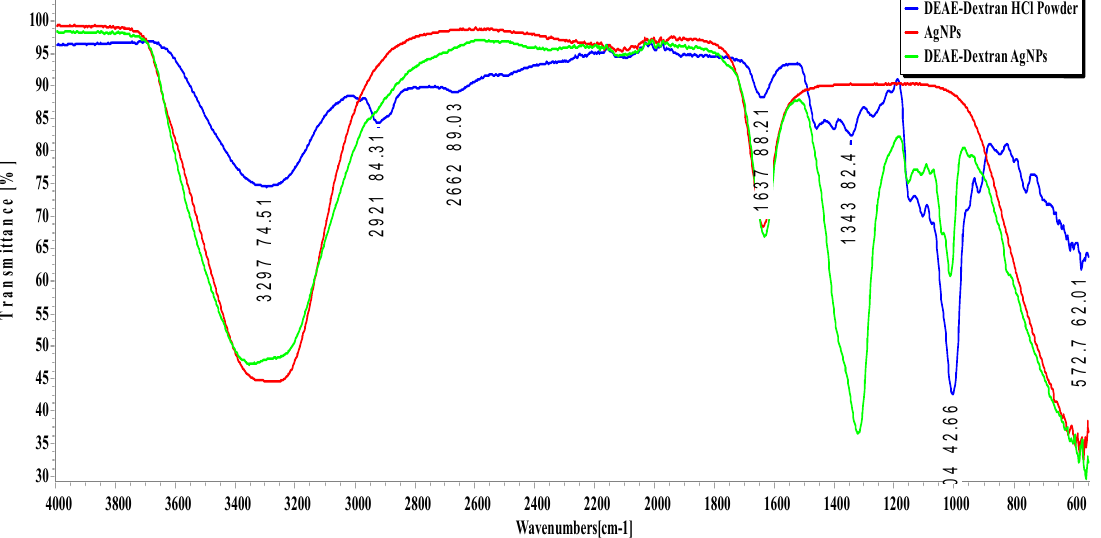
Figure 4. FTIR spectrum of AgNPs, DEAE-Dextran HCl, and DEAE-Dextran AgNPs.